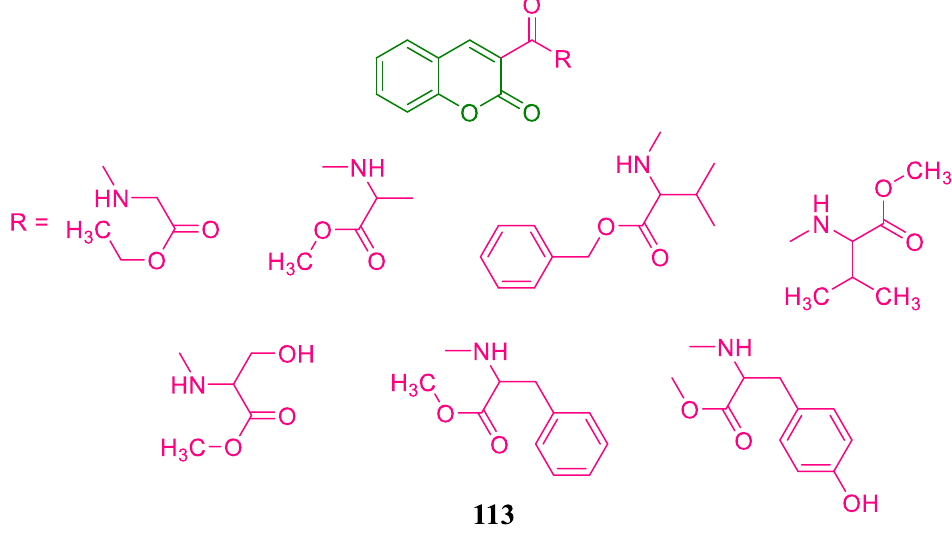
Figure 92. Coumarin-amino acid derivatives.